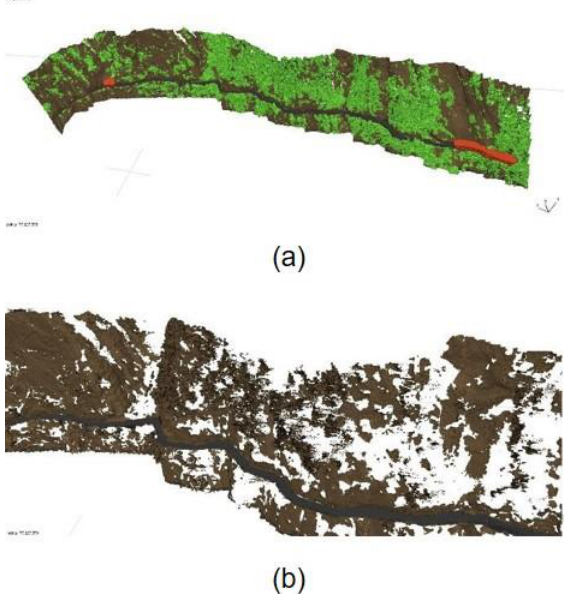
Figure 5. a) Semi-automatic classification in AMS; b) Critical issues found cause of complex and steep geography. Red, green, brown and black points represent building, vegetation, ground and road respectively.